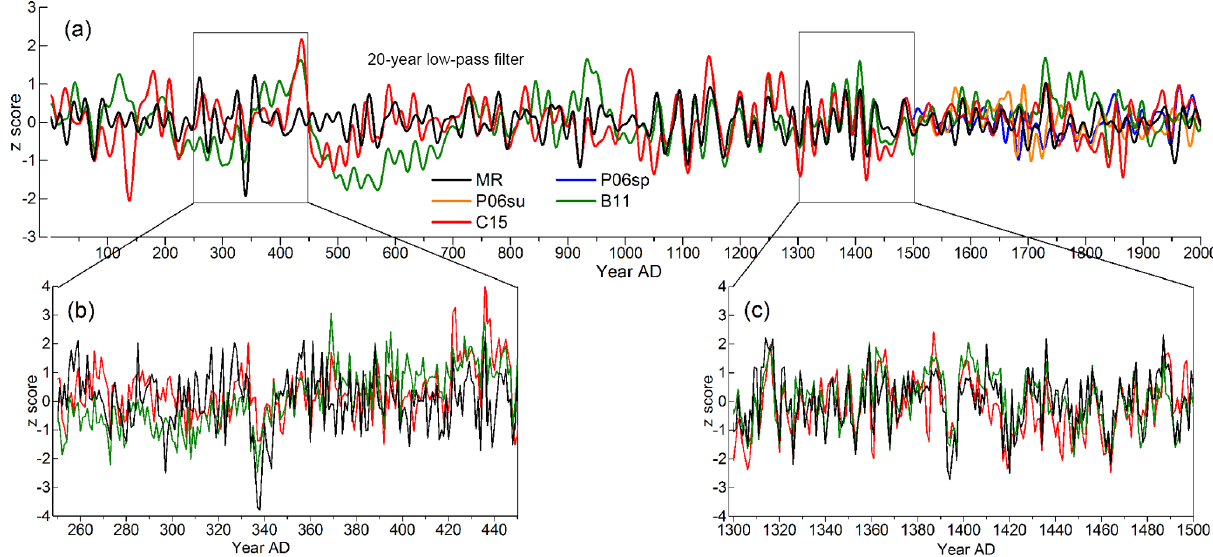
Figure 6. Smoothed hydroclimate reconstructions from AD1 to 2000: (a) 20-year low-pass-filtered reconstructions, (b) annual fluctuations from AD250 to 450 and (c) those from AD1300 to